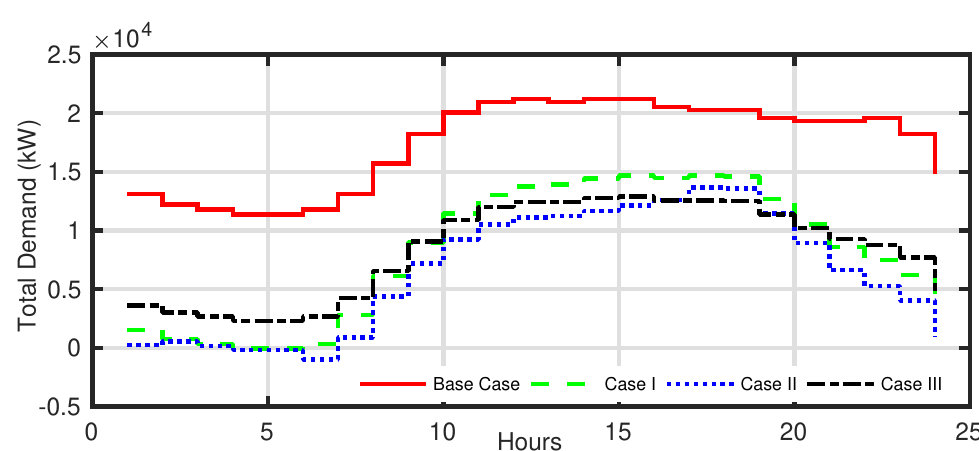
Figure 9. Hourly active power demand of 108-bus Indian distribution network.